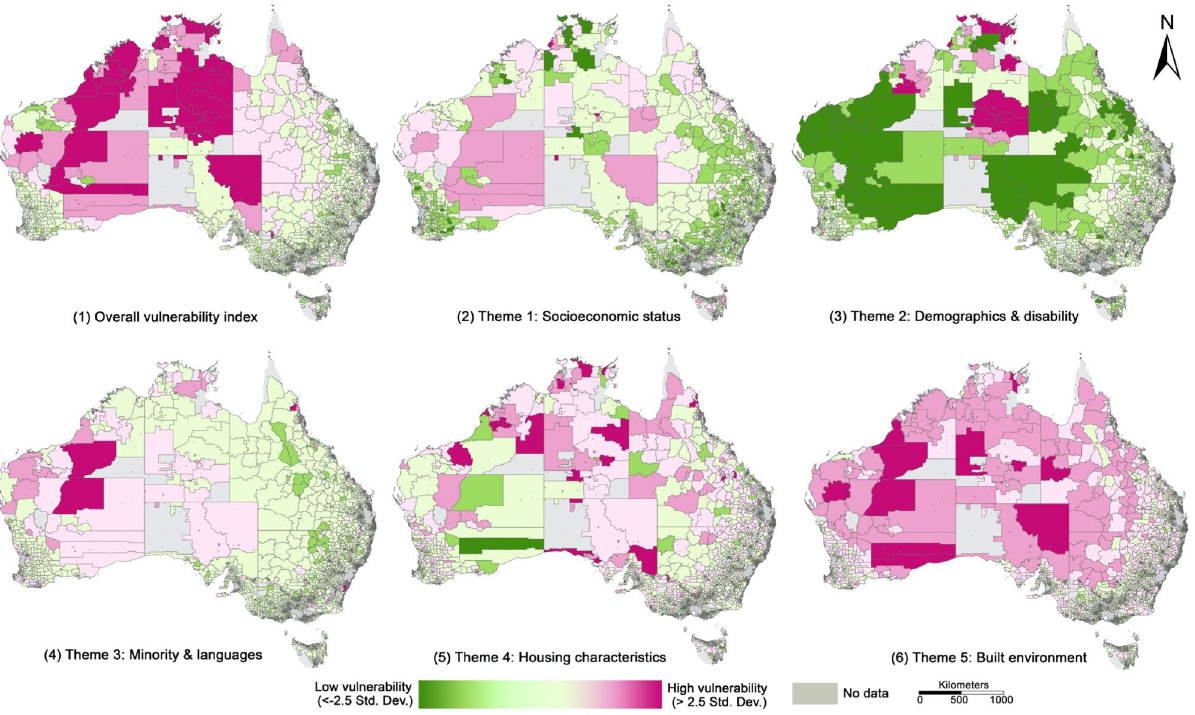
Figure 3. Spatial patterns of the vulnerability index in rural areas for (1) overall (combining five themes); (2) Theme 1 (socioeconomic status); (3) Theme 2 (demographics and disability); (4) Theme 3 (minority and languages); (5) Theme 4 (housing characteristics); (6) Theme 5 (built environment). The vulnerability index is classified by standard deviation with a colour ramp from green indicating low vulnerability (smaller than -2.5 standard deviation) to dark pink indicating high vulnerability (larger than 2.5 standard deviation). Grey areas have no data given these areas with the number of populations less than 50 contain census data randomly assigned by Australian Bureau of Statistics due to the concern of data